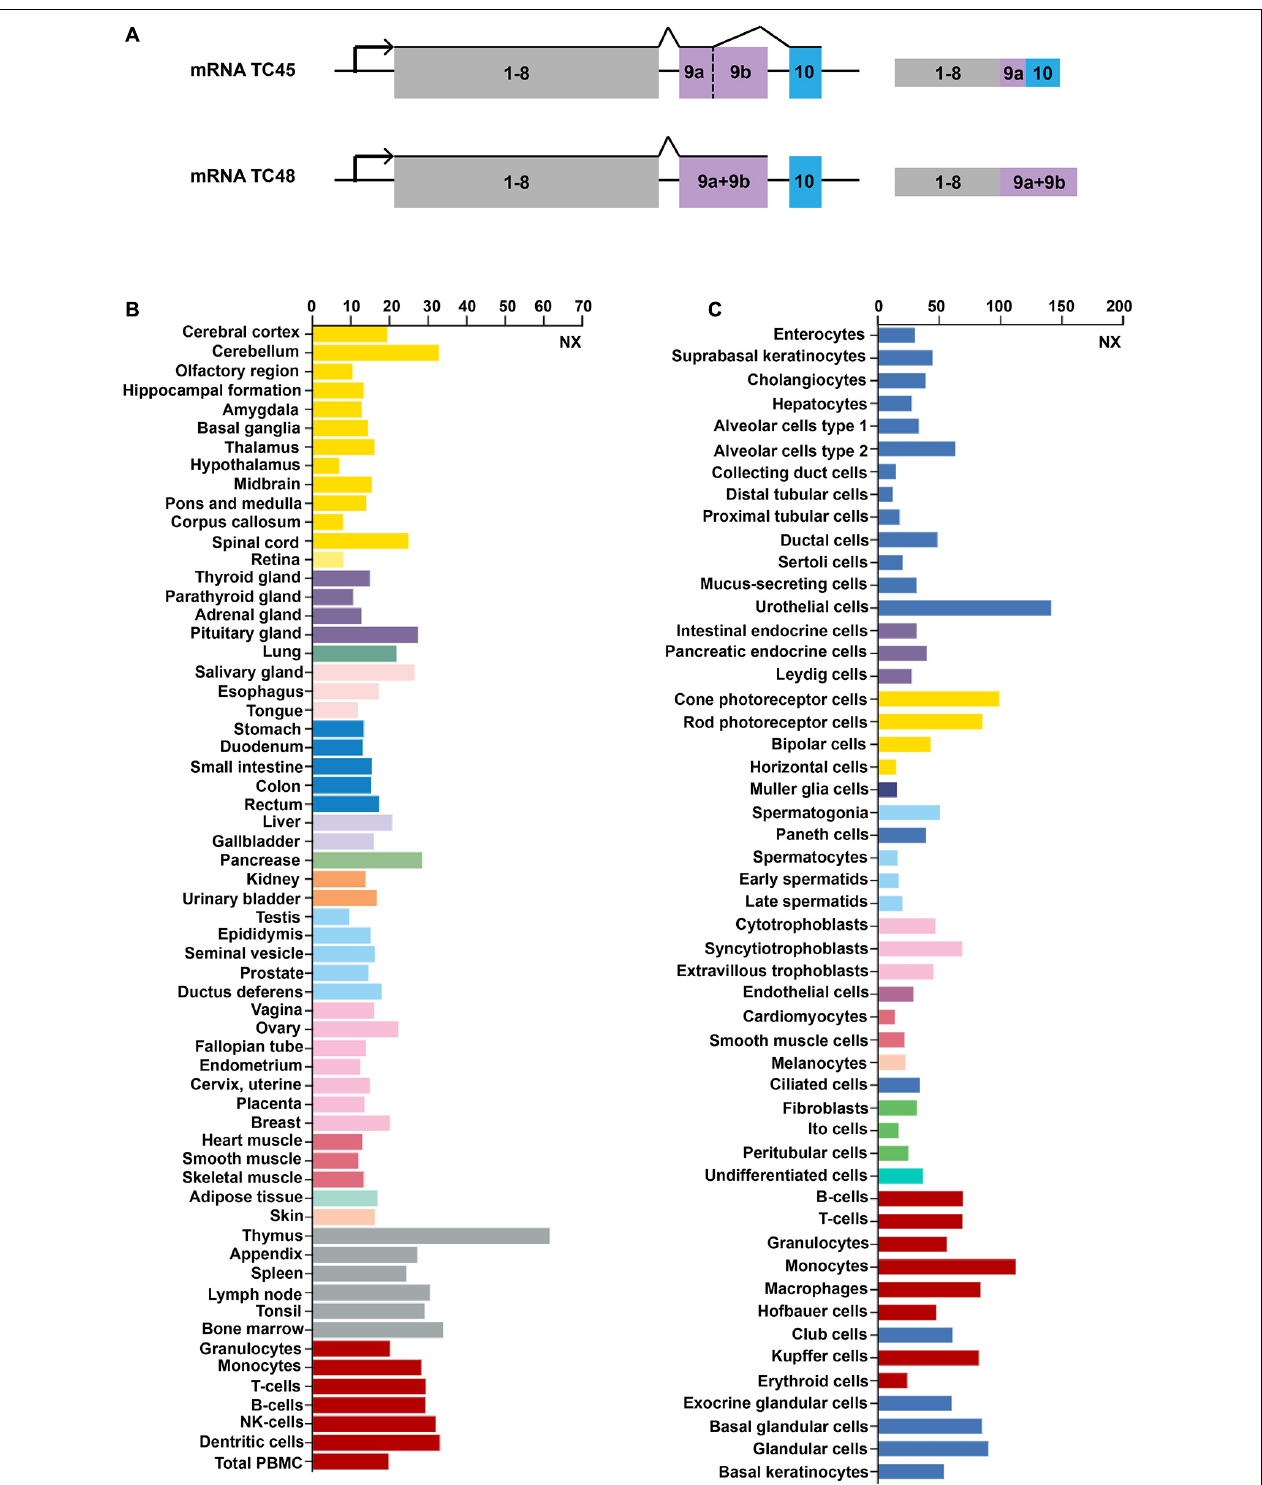
FIGURE 1 | Gene structures and expression profiles of TCPTP. (A) Gene structures of TCPTP (modified according to reference Bussieres-Marmen et al., 2014). Exon 9a is identified in both TC45 and TC48, while exon 9b only presents in TC48. TC45 is transcribed by exon 9a and exon 10, while TC48 is transcribed by exon 9a + 9b, but without exon 10. (B) Expression profiles of TCPTP in different normal tissues. (C) Expression profiles of TCPTP in various normal cells. Data are available on https://www.proteinatlas.org/. NX represents the consensus normalized expression level.